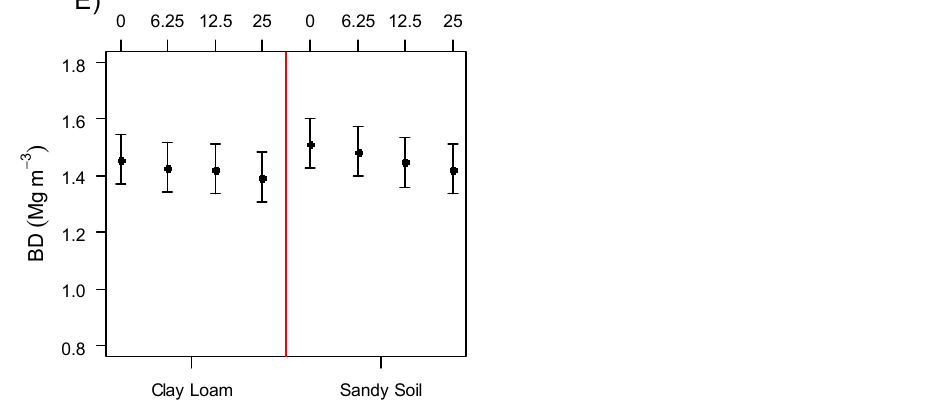
Figure 3. Effect of biochar amount on soil physical and chemical properties in clay loam and sandy soil. C: carbon; N: nitrogen; C/N: atomic ratio; TP: total porosity; BD: bulk density. ( A ) Carbon content; ( B ) Nitrogen content; ( C ) Carbon and Nitrogen ratio; ( D ) Total porosity; ( E ) Bulk density.